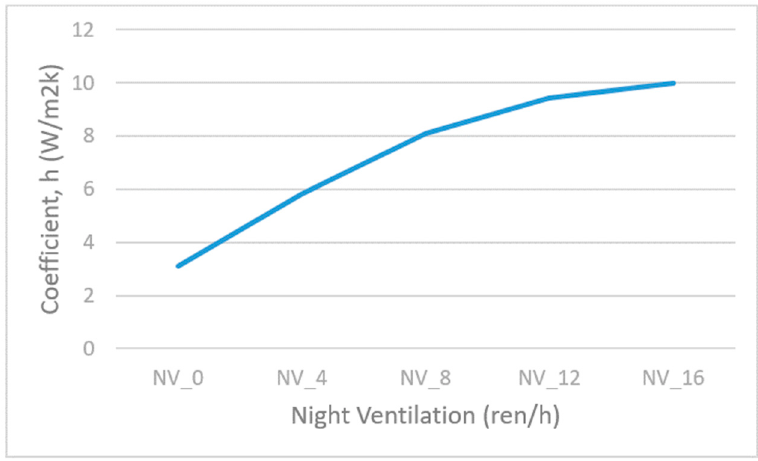
Figure 11. Results of heat transfer coefficients (activation of night ventilation).